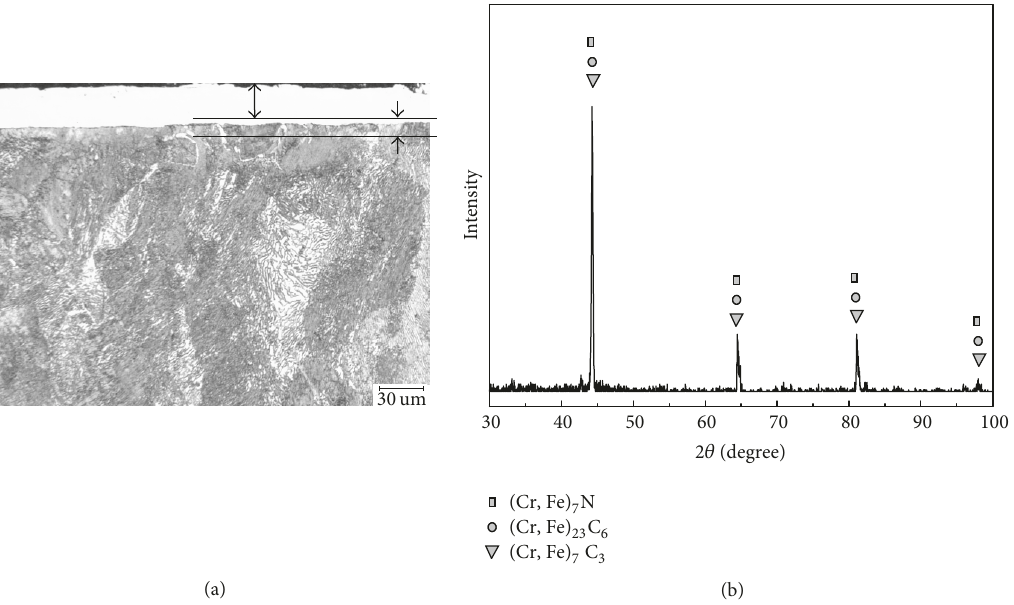
Figure 1: (a) OM micrograph of chroming layer; (b) XRD spectra of chroming coatings.